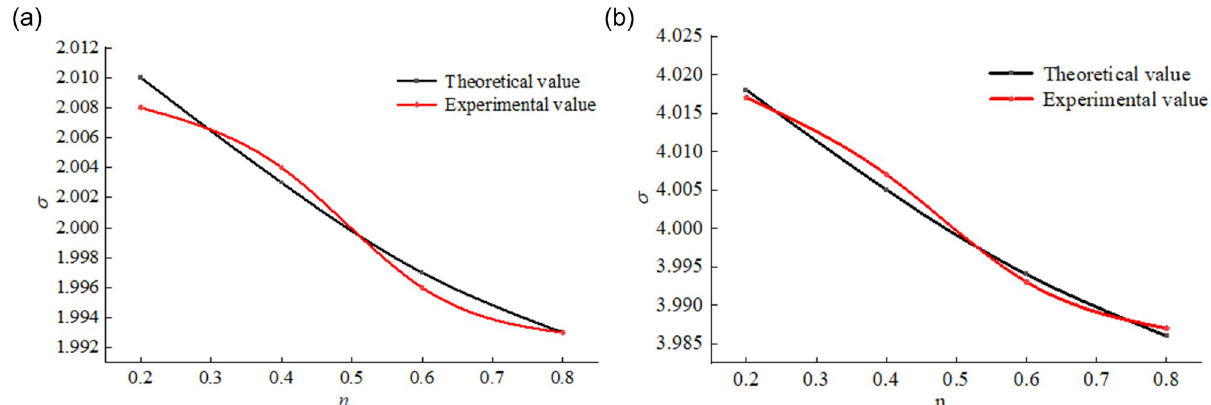
Fig 7. Comparison of the test and calculation results. (a) ε = 0.066. (b) ε = 0.116.